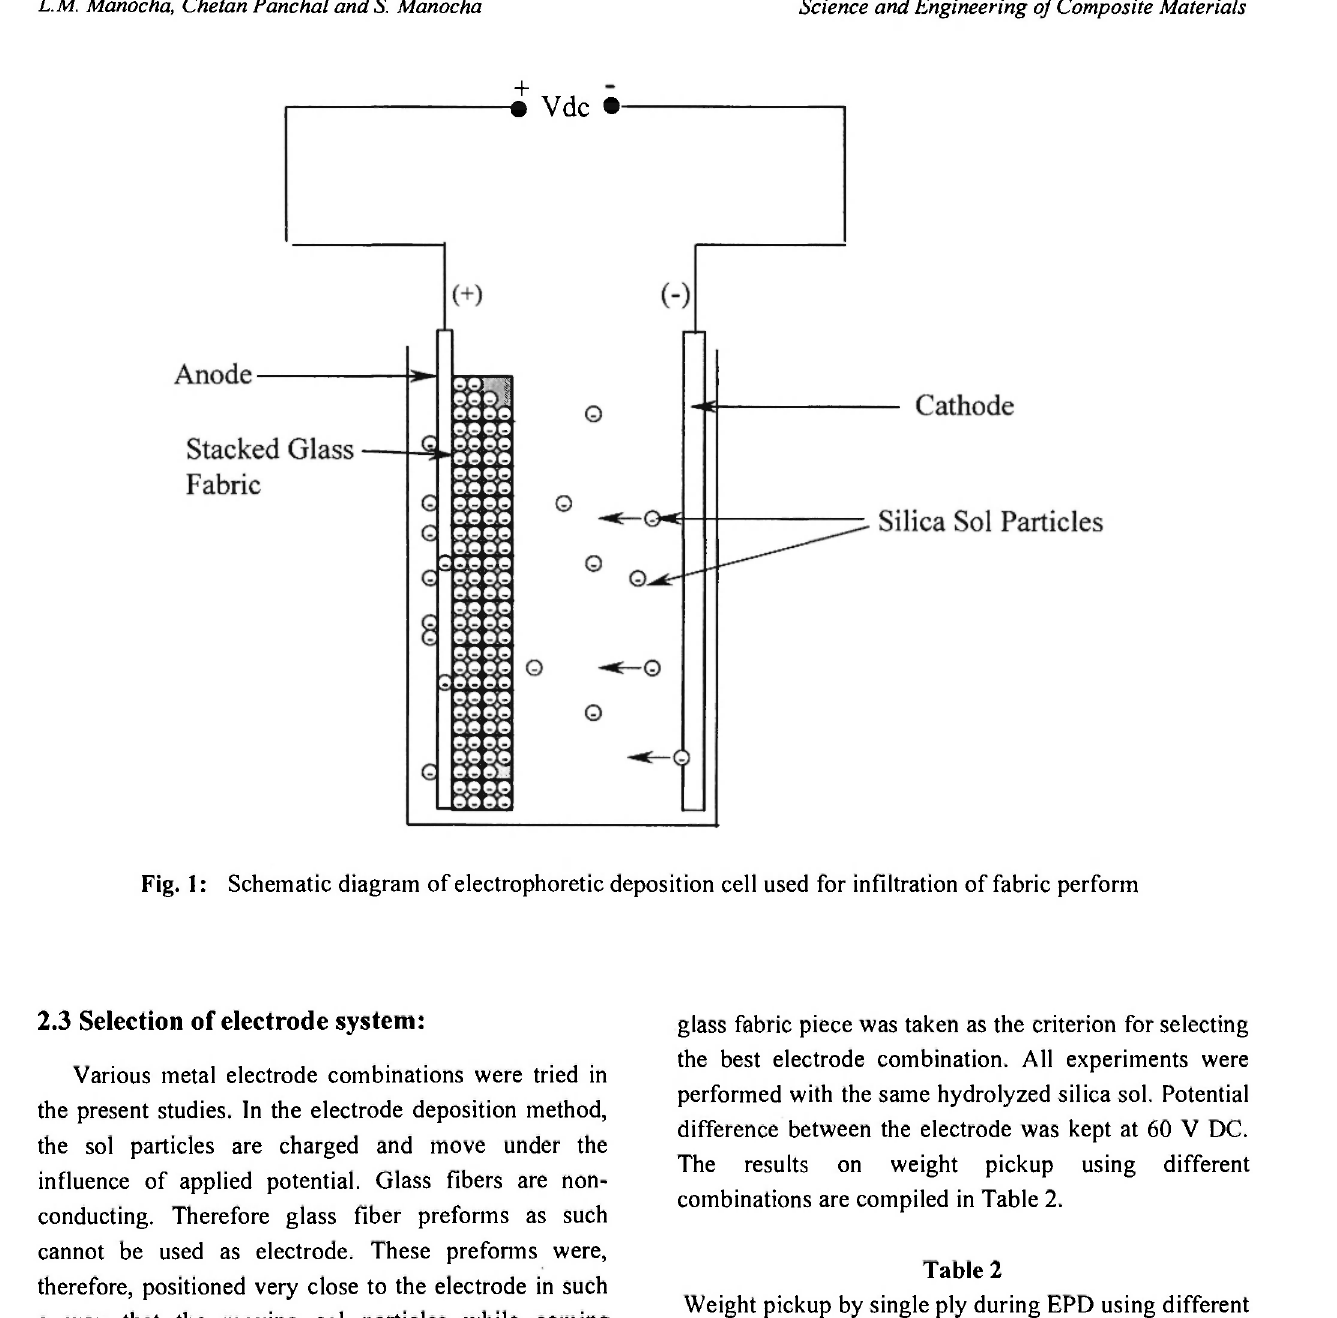
Weight pickup by single ply during EPD using different electrode